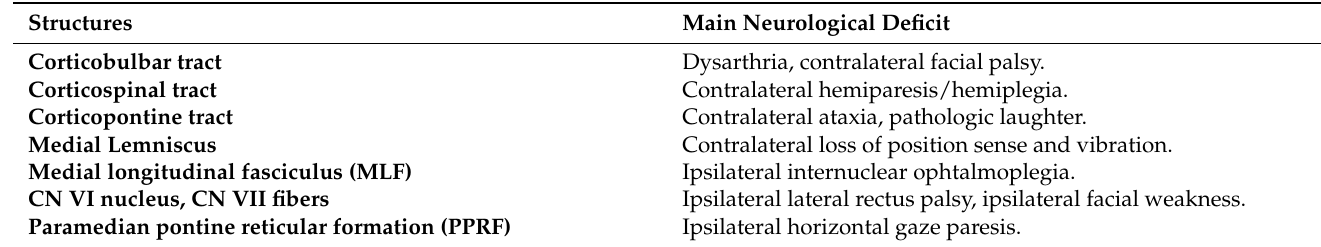
Table 5. Structures involved in anteromedial pontine infarction and corresponding neurological deficit (modified from [10]) .